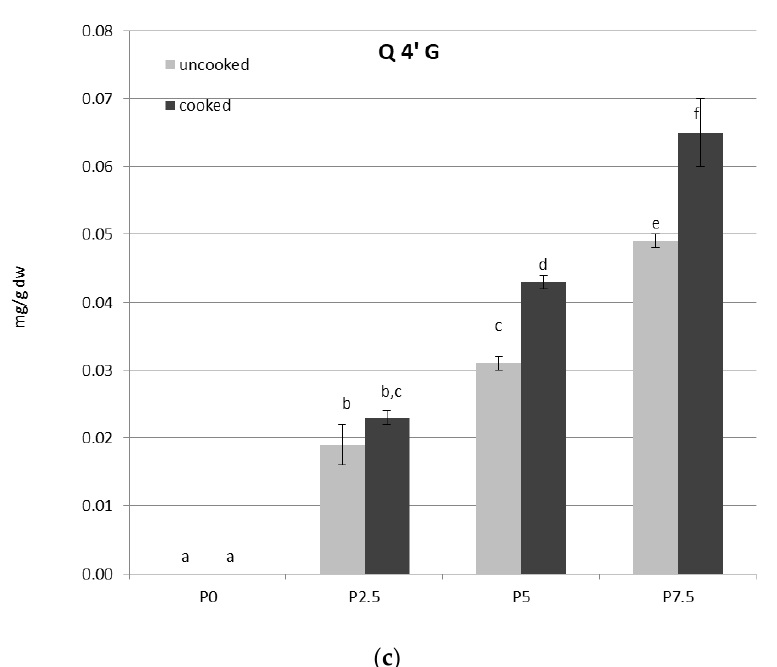
Figure 1. Comparison of total phenolic acid (PAC) ( a ), quercetin (Q) ( b ), and quercetin 4′-gluciside content (Q 4′ G) ( c ) of uncooked and cooked pastas fortified with onion skin powder. P0—control pasta; P2.5–7.5 pastas fortified with 2.5–7.5% ( m / m ) of onion skin powder. Different letters indicate significant difference ( p < 0.05). Table 1. Characteristics of raw materials used in the production of fortified pastas.